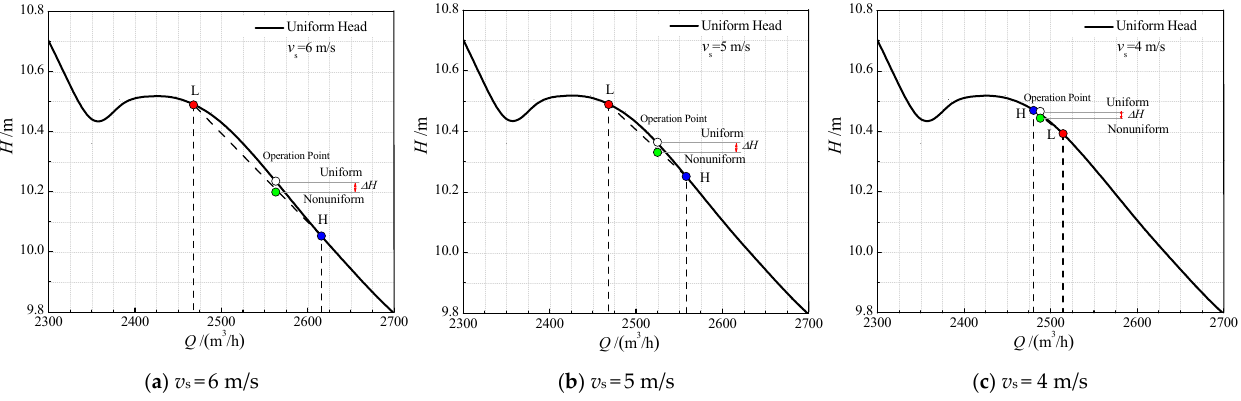
Figure 9. Operating point comparison between tube L and H, at partial stall condition. Pre-stall occurs in the ship speed range from 4 m/s to 7 m/s: both tube L and tube H operates at near-stall condition. As shown in the movement of blue point from Figure 10a to Figure 10c, tube H approaches close to the hump due to the reducing ship speed, with consequent a flow rate drop from 2700 m 3 /h to 2480 m 3 /h; namely, tube H operates near the hump in this ship speed range. After climbing over the hump, tube L continues to move forward due to the reducing ship speed, with consequent an increase in flow rater even to the maximum at ship speed 4 m/s; it is noticed that the maximum value is about 2515 m 3 /h, slight larger than 2450 m 3 /h, so that tube H also operates near the hump. Hence, both tube L (near-stall) and tube H (near-stall) are responsible for a pre-stall behavior in the parallel system, i.e., waterjet pump under nonuniform inflow.